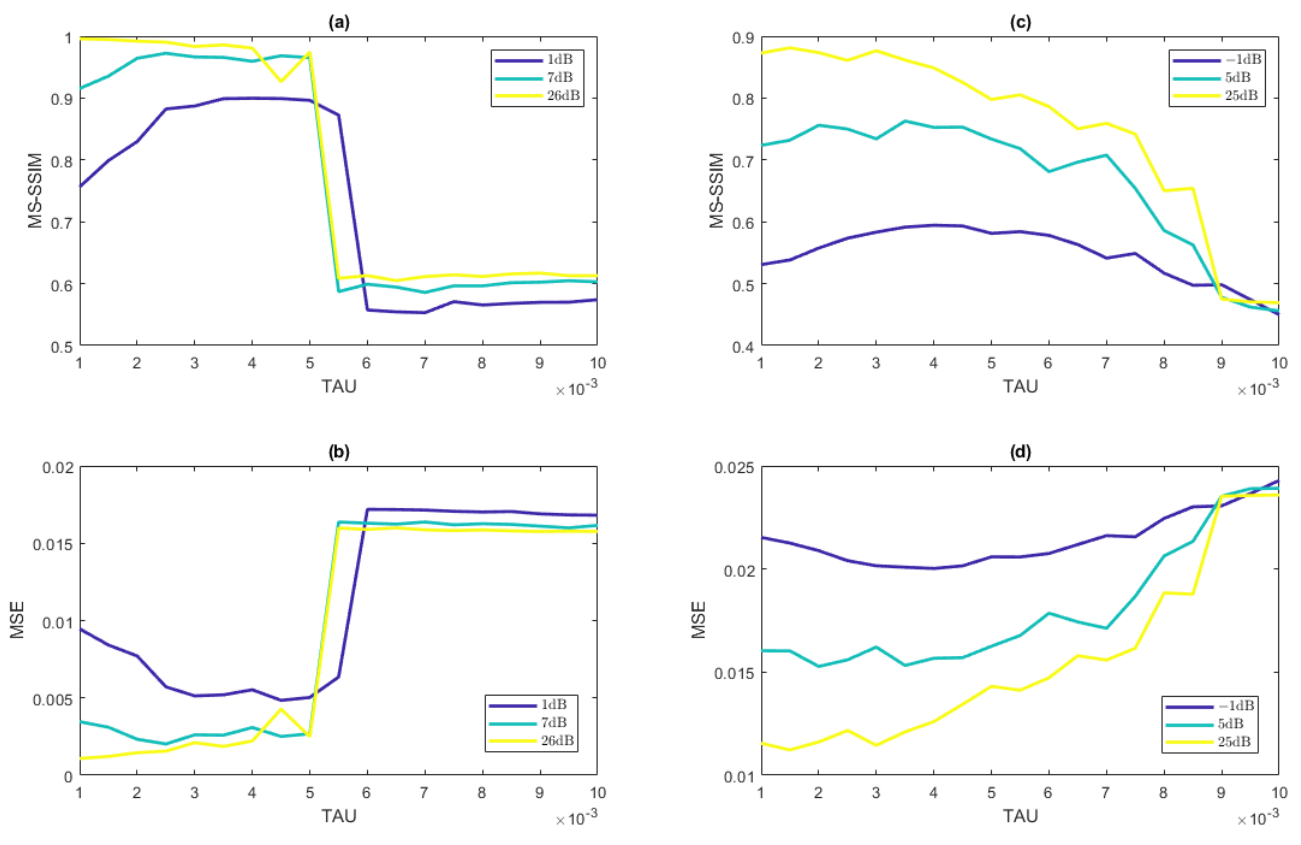
Figure 8. Average MSE ( a ) and average MS-SSIM ( b ) of the reconstructed cylinder IPD as well as average MSE ( c ) and average MS-SSIM ( d ) of the reconstructed vessel-like IPD, averaged over five trials for each value of the regularization parameter considered. Low, medium, and high values of SNR are considered for